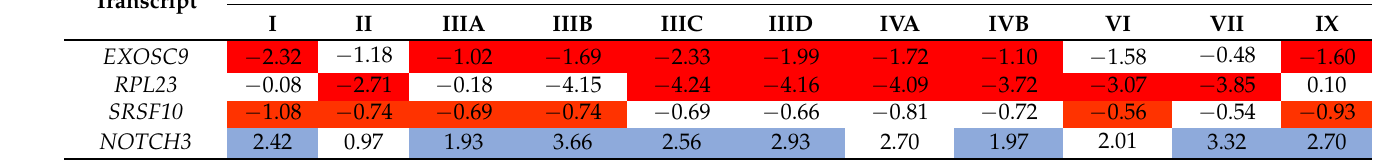
Table 2. Genes coding for proteins involved in gene expression regulation whose transcripts revealed significantly changed levels in at least six MPS types relative to the control cells. The colored boxes indicate statistically significant differences (at FDR < 0.1; p < 0.1) between MPS and control cell lines: red boxes indicate down-regulation, and blue boxes indicate up-regulation relative to control. Log 2 FC of Levels of Selected Transcripts in Different MPS Types vs. HDFa